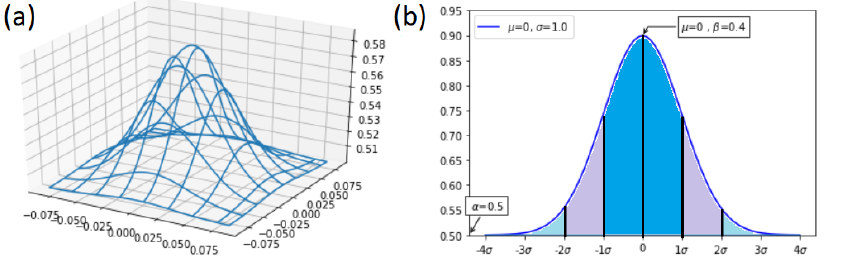
Figure 2. Gaussian bell cut from − 2 σ to 2 σ : ( a ) 3D Gaussian bell, ( b ) a typical 2D section of the 3D Gaussian